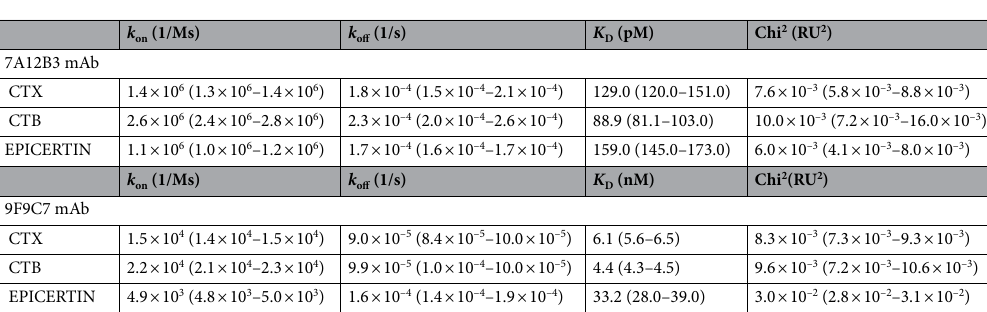
Table 2. Association and dissociation constants of CTX, CTB and EPICERTIN binding to 7A12B3 and 9F9C7 mAbs generated by surface plasmon resonance.